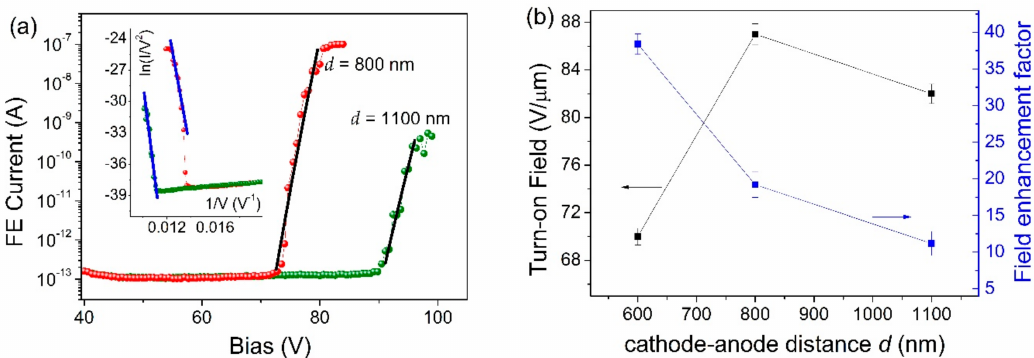
Figure 4. E ff ect of cathode–anode separation distance variation on the FE I-V characteristics. ( a ) Curves are measured for d = 800 nm and 1100 nm and are compared to theoretical FN behavior (solid lines). Inset: FN-plots and linear fittings. ( b ) Dependence of the turn-on field and of the field enhancement factor on the cathode–anode separation distance d in the range 600 nm–1100